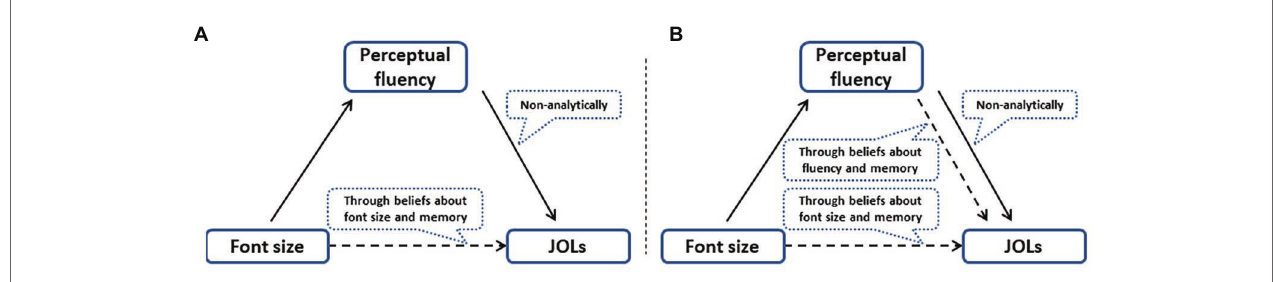
FIGURE 5 | The mechanism of font size effect. Previous studies suggested that there are two main mechanisms for the font size effect (as shown in A ). One is belief theory, which believes that people make JOLs analytically through beliefs about font size and memory, and the other one is fluency theory, which believes that people make JOLs non-analytically through subjective feeling about fluency. But according to the results of this study, perceptual fluency can affect JOLs not only in a non-analytical way, but also an analytical way (as shown in B